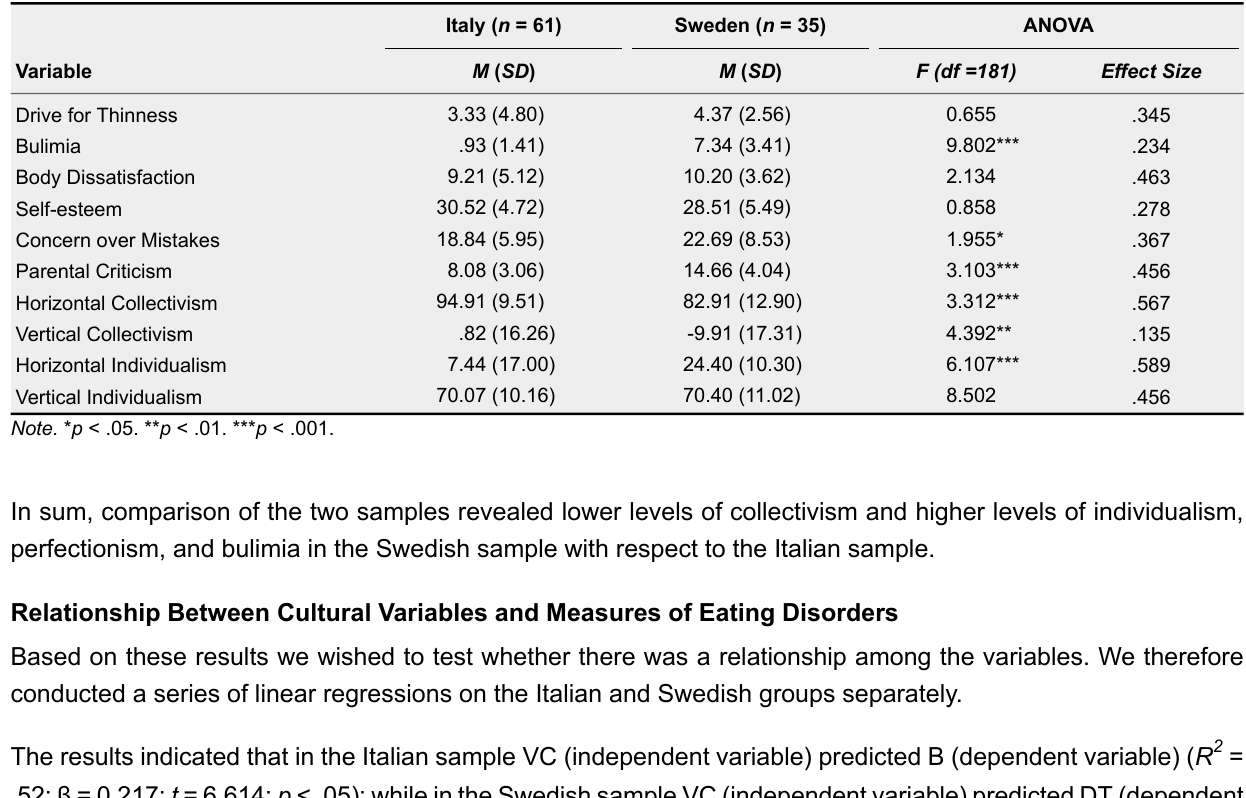
Comparison of Mean Scores of Italian and Swedish